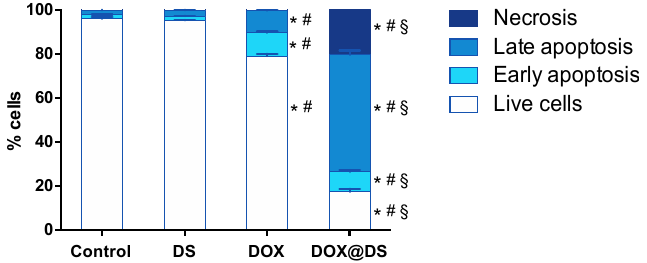
Figure 6. Induction of cell death in 1301 cells by blank dendrimersomes (DS), free doxorubicin (DOX) and doxorubicin-loaded dendrimersomes (DOX@DS). Incubation for 72 h, then FITC-Annexin V / 7AAD staining, flow cytometry. Data are presented as mean ± S.D. (n = 3). * p < 0.05 vs. control group; # p < 0.05 vs. DS group; § p < 0.05 vs. DOX group.